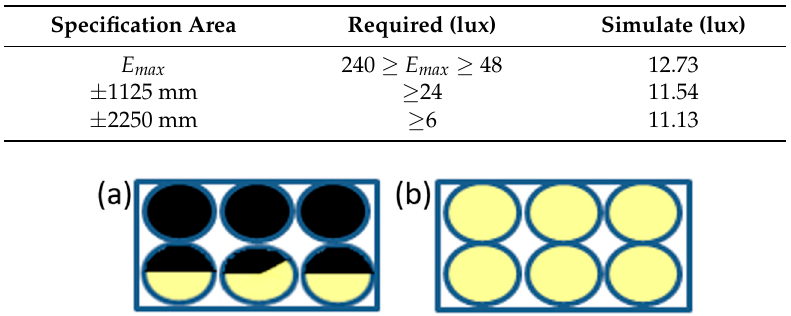
Figure 5. ( a ) System operation diagrams when operating in low beam mode and ( b ) high beam mode. Table 4. Comparison of simulated results and illuminance regulations of the light field in high beam mode.